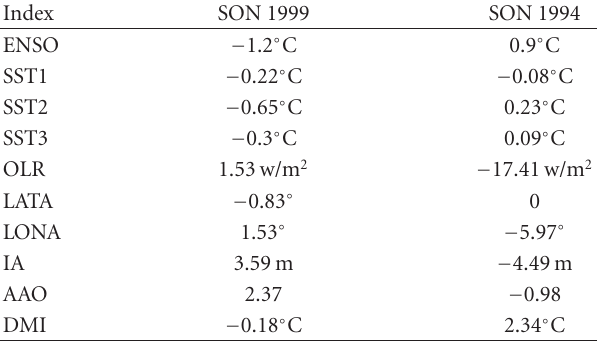
Figure 2: Areas where SST indexes are defined. Table 1: Index anomalies for Spring 1999 and 1994. Anomalies are computed from 1961–2010 seasonal